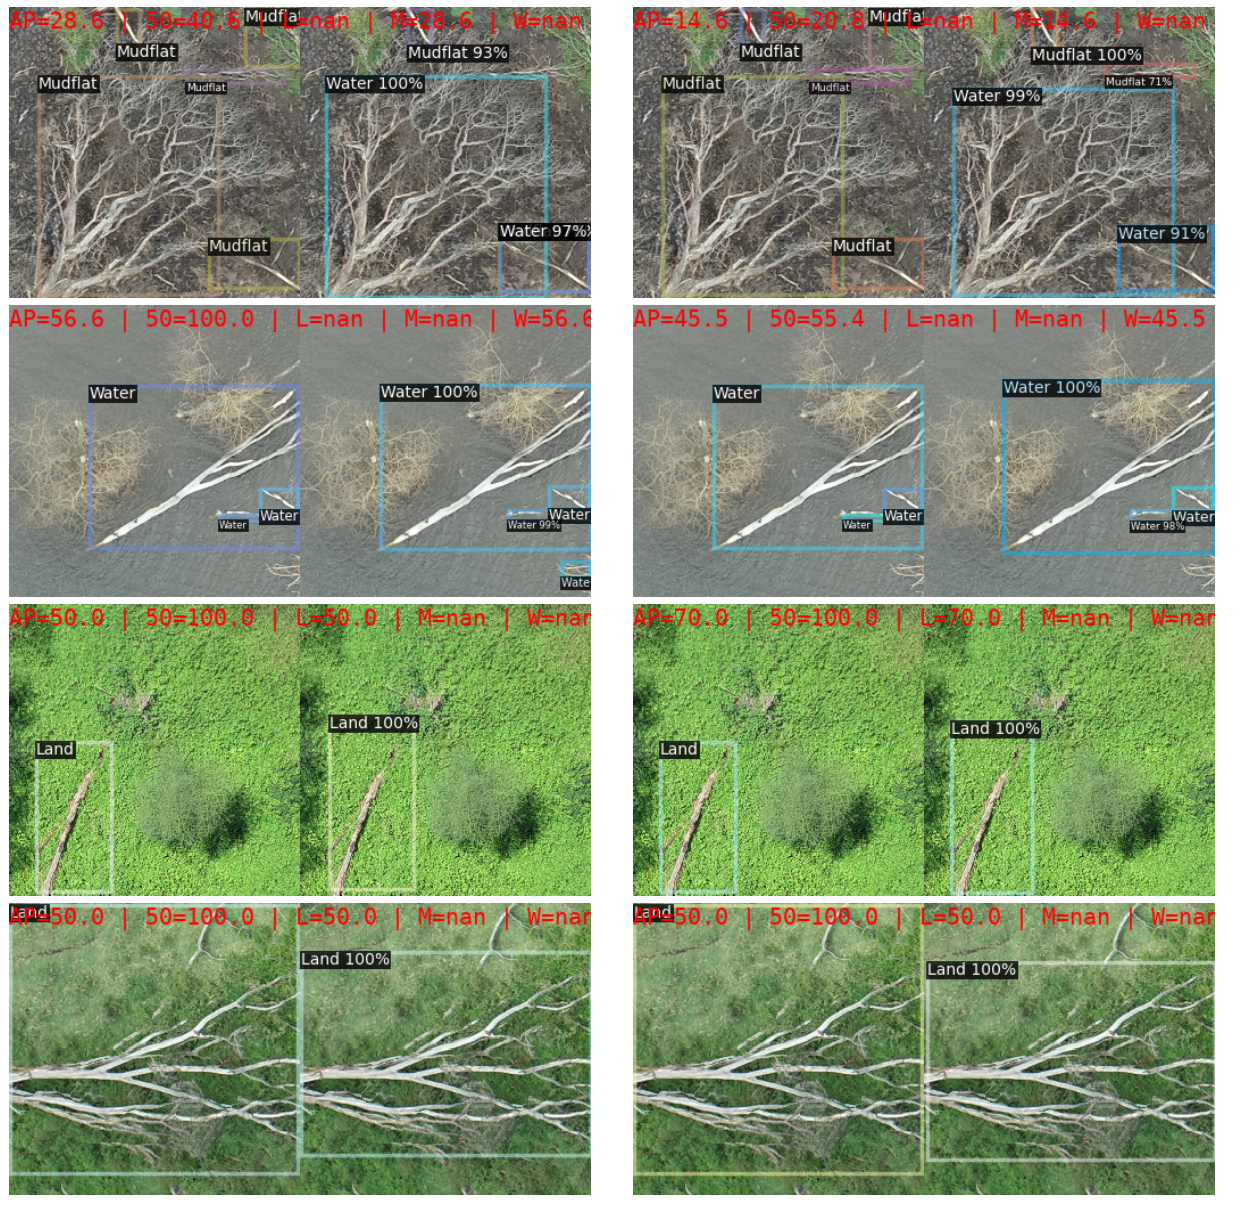
Figure 4. Sample results from different scenes using RetinaNet, Figure 5. Sample results from different scenes using with average precision (AP) averaging over all IoU levels in Faster-RCNN, with average precision (AP) averaging over all [0.5, 0.95], step size 0.05 and (50 being precision at IoU ≥ 0 . 5 ) IoU levels in [0.5, 0.95], step size 0.05 and (50 being precision on three classes: Dead Tree in Water (W), on Land (L), and on at IoU ≥ 0 . 5 ) on three classes: Dead Tree in Water (W), on Mudflat (M). Ground truths are shown on the left and predicted Land (L), and on Mudflat (M). Ground truths are shown on the bounding boxes on the right. The confidence levels (%) are left and predicted bounding boxes on the right. The confidence shown on the bounding boxes. levels (%) are shown on the bounding